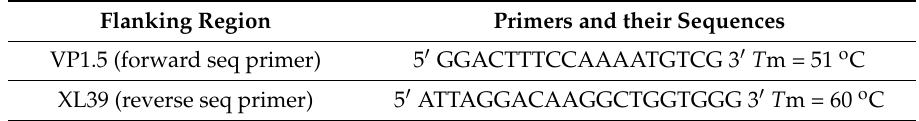
Table 1. Primers to flanking regions of TruORF commercially delivered by the manufacturer (OriGene Technologies, Inc, Rockville, MD,